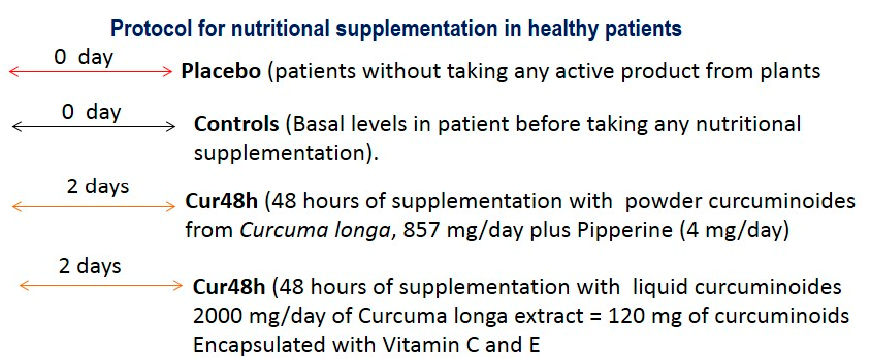
Figure 2. (protocol). Short-Term AFA Bluegreen Extract or Curcumin Administration over 48 Consecutive Hours with Two Different Formulations (Powder or Liquid